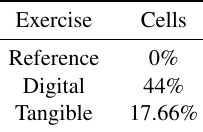
Table 3: Highest max and summed depth of depressions (ft)